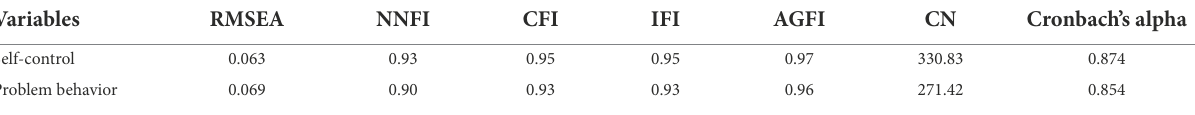
TABLE 2 Scale reliability and validity